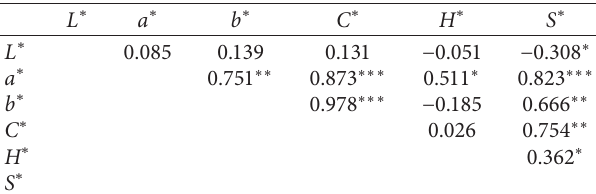
hue angle were positively linked to each other ( r � 0.511 ∗ ).